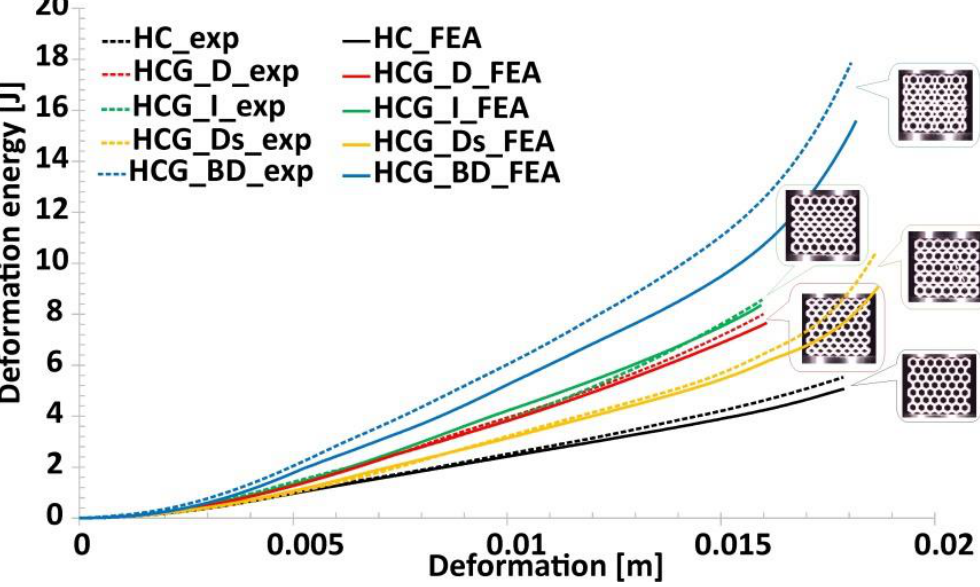
Figure 27. Comparison of deformation energy plots obtained from the FE analysis and experimental tests.